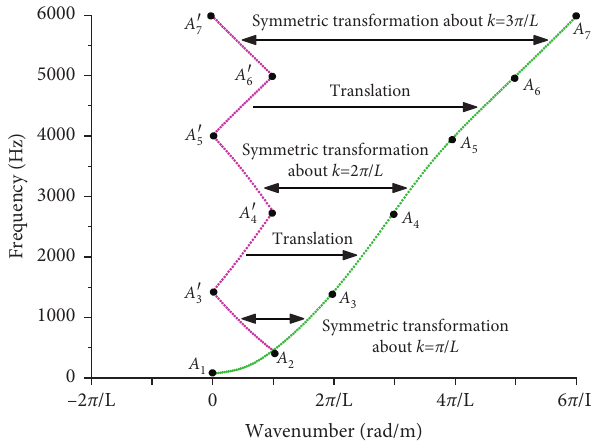
Figure 3: Selection of the dispersion curve of wave A .